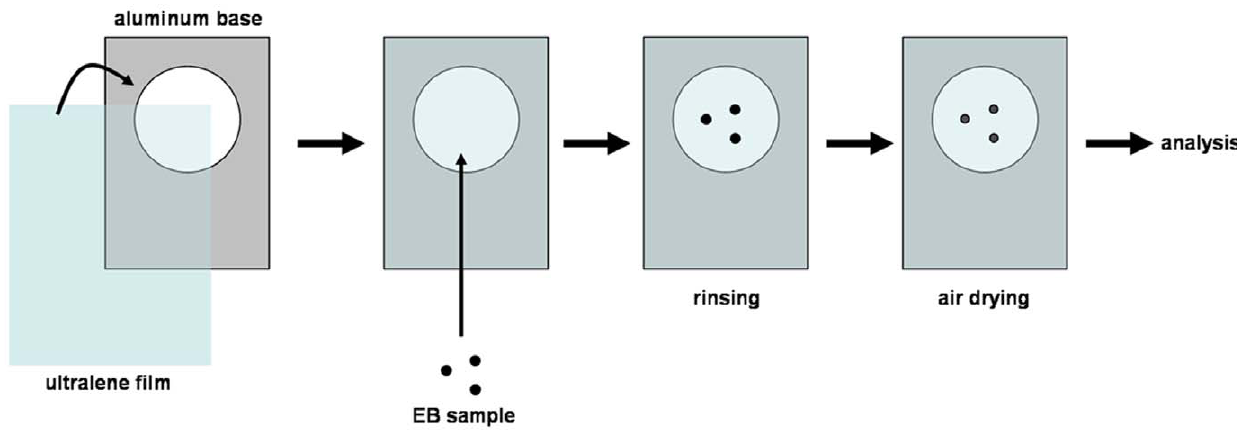
Figure 1. Sample assembly. In order to fixate EB samples on ultralene film, an aluminum base was used and film was attached to it with regular tape. EBs were water rinsed and air dried on this assembled piece.